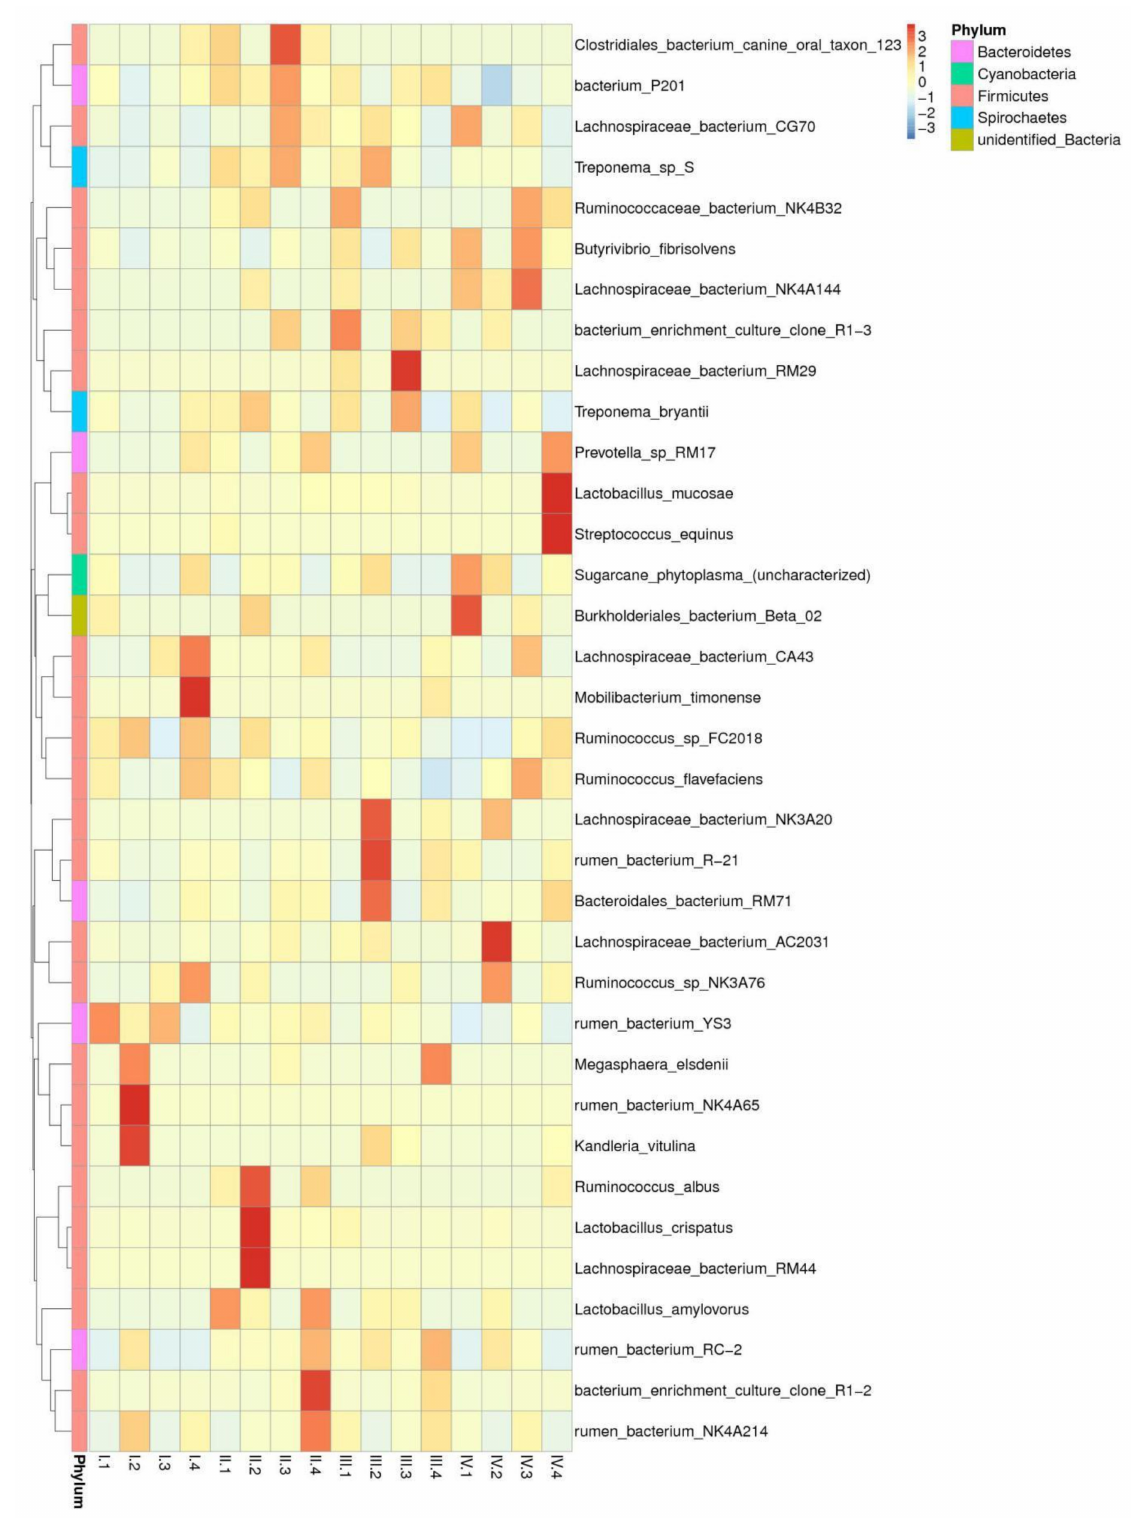
Figure 6. The relative abundance cluster map of species. Sample information is listed in the longitudinal direction, and species annotated information is listed in the crosswise direction. The species cluster tree is shown on the left-hand side, and the corresponding values of the intermediate heat map are the Z values obtained after the relative abundance of each row of species, which has been